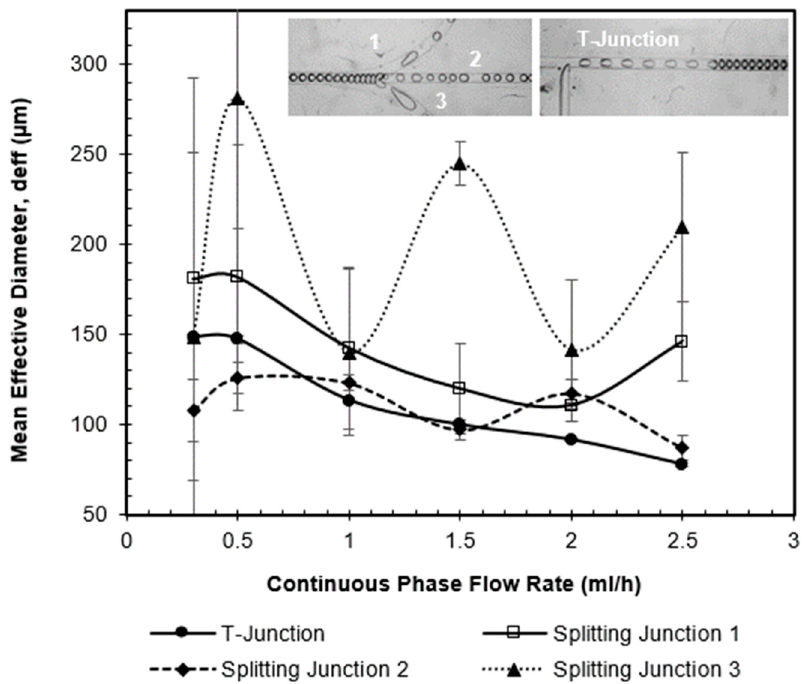
Figure 15. Average droplet size distribution with respect to different Q c ranging from 0.5 mL/h to 2.5 mL/h in asymmetrical bifurcating junction. Image indicates the region of interest for the droplet measurement. Error bars indicate the standard deviation in effective droplet size measurement of 30 droplets under fixed experimental condition.